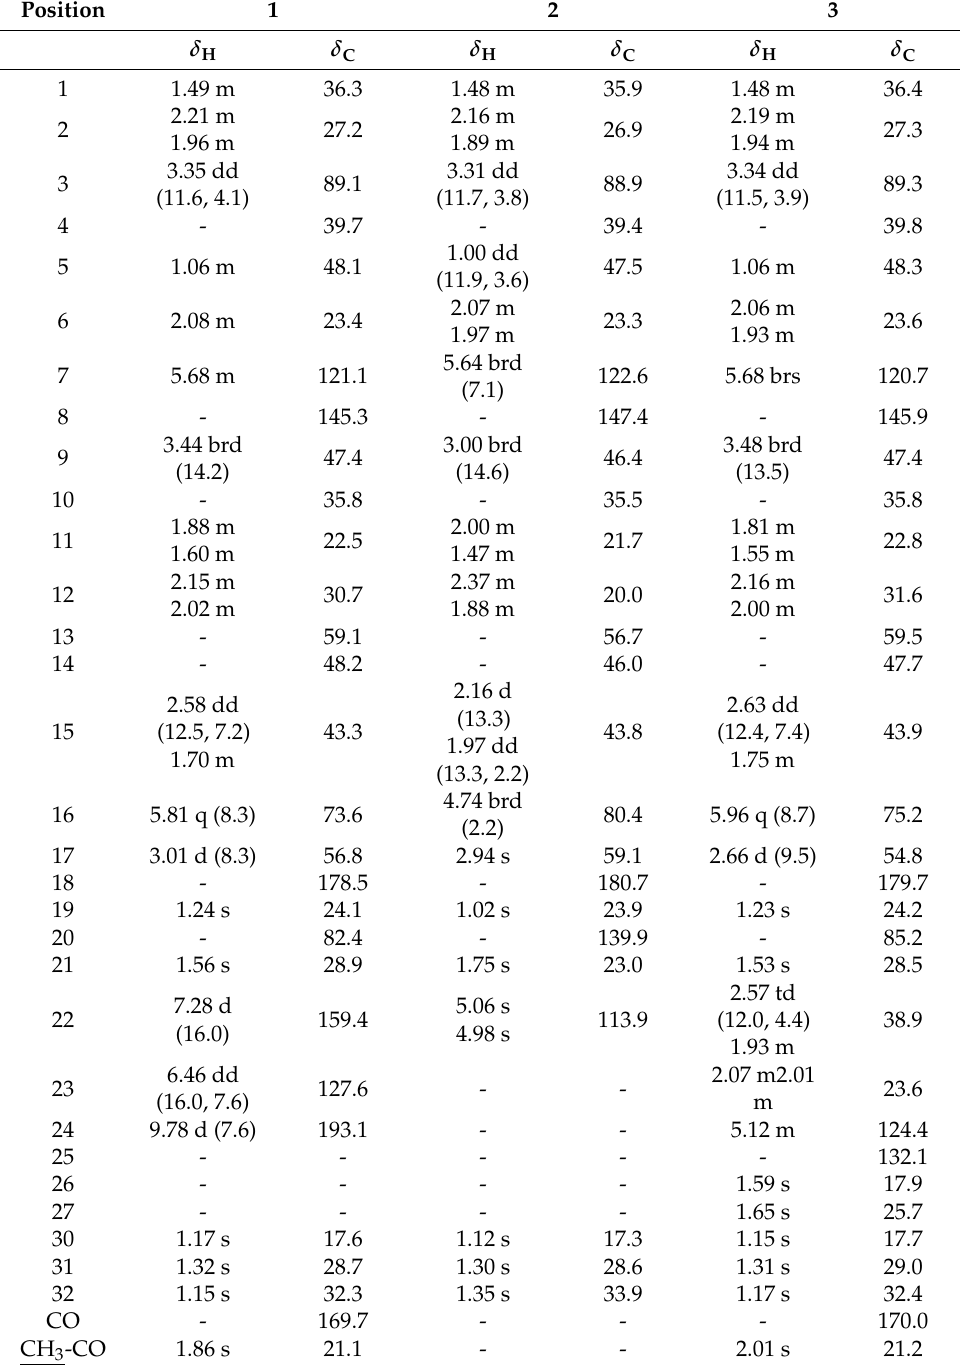
Table 1. 1 H and 13 C NMR data of aglycon part of compounds 1 – 3 (35 ◦ C, C 5 D 5 N, J in Hz) a